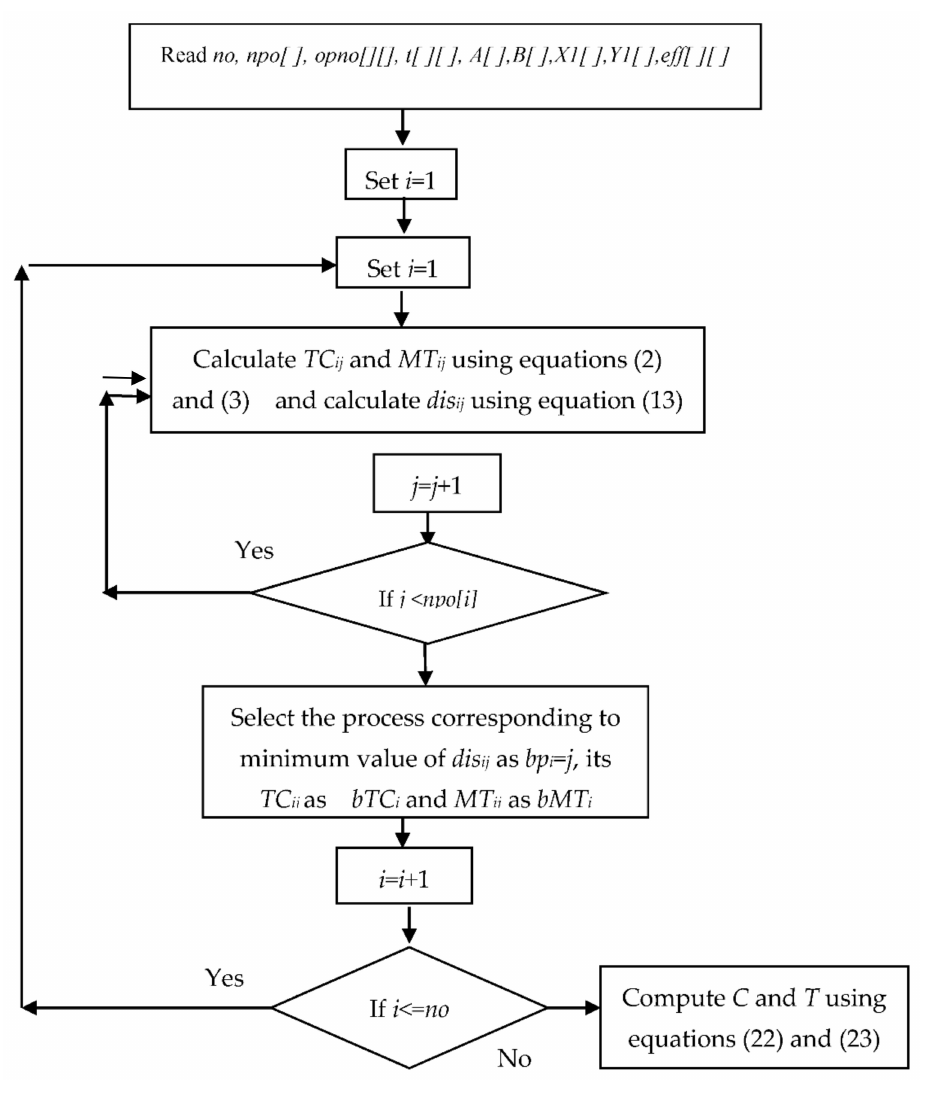
Figure 2. Flow chart of univariate search